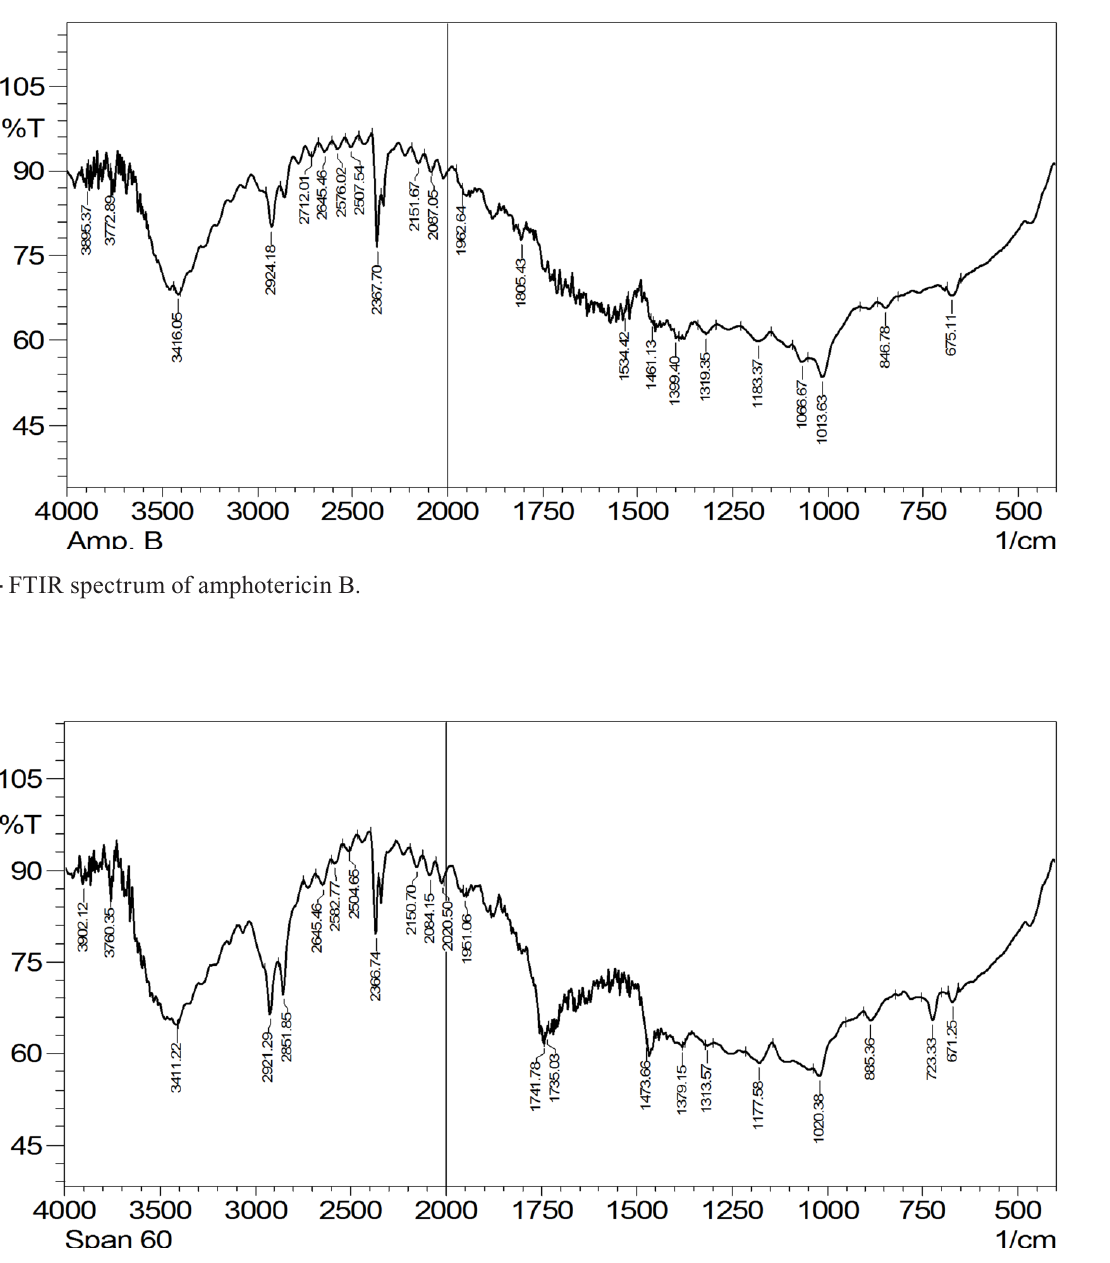
FIGURE 2 - FTIR spectrum of span